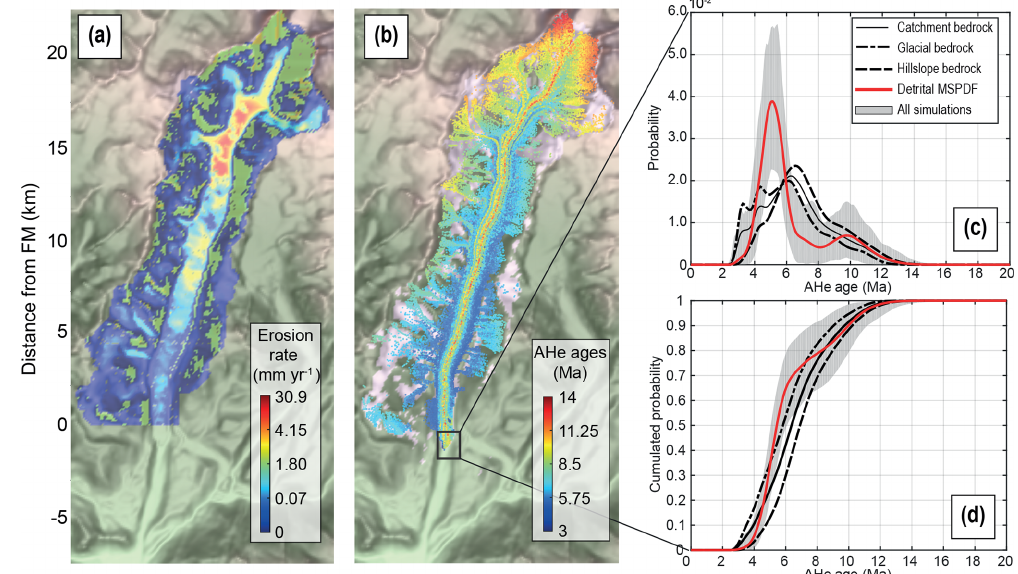
Figure 9. Non-uniform erosion model experiment with (a) the erosion rate, (b) spatial AHe age distribution of particles, (c) detrital AHe age probability distributions, and (d) their cumulative probability for the frontal moraine. The grey shaded area represents the range of the inferred 10000 detrital SPDFs from the sampling process. The black square in (b) shows the frontal moraine (FM) location. MSPDF: mean synoptic probability distribution